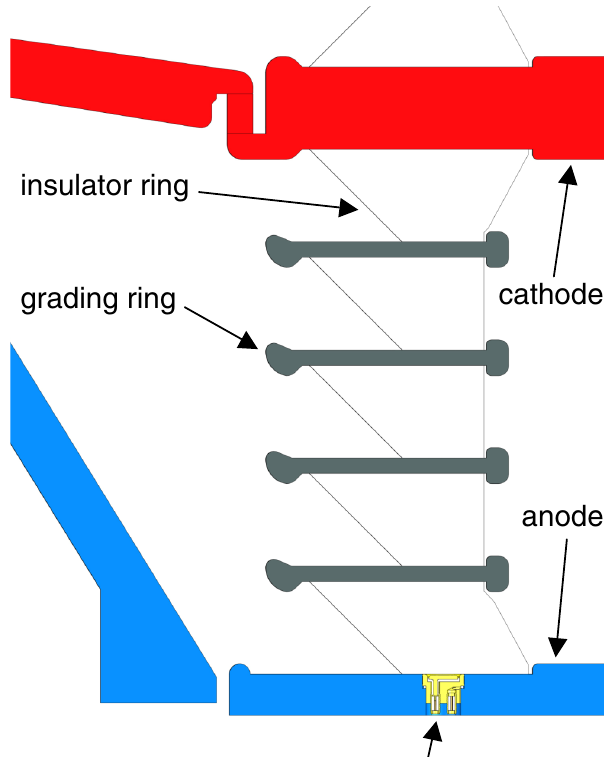
FIG. 8. (Color) Location of a differential-output D -dot voltage monitor in the anode of the Z -accelerator’s B-level insulator stack. (All four stack levels are illustrated by Fig. 1.)